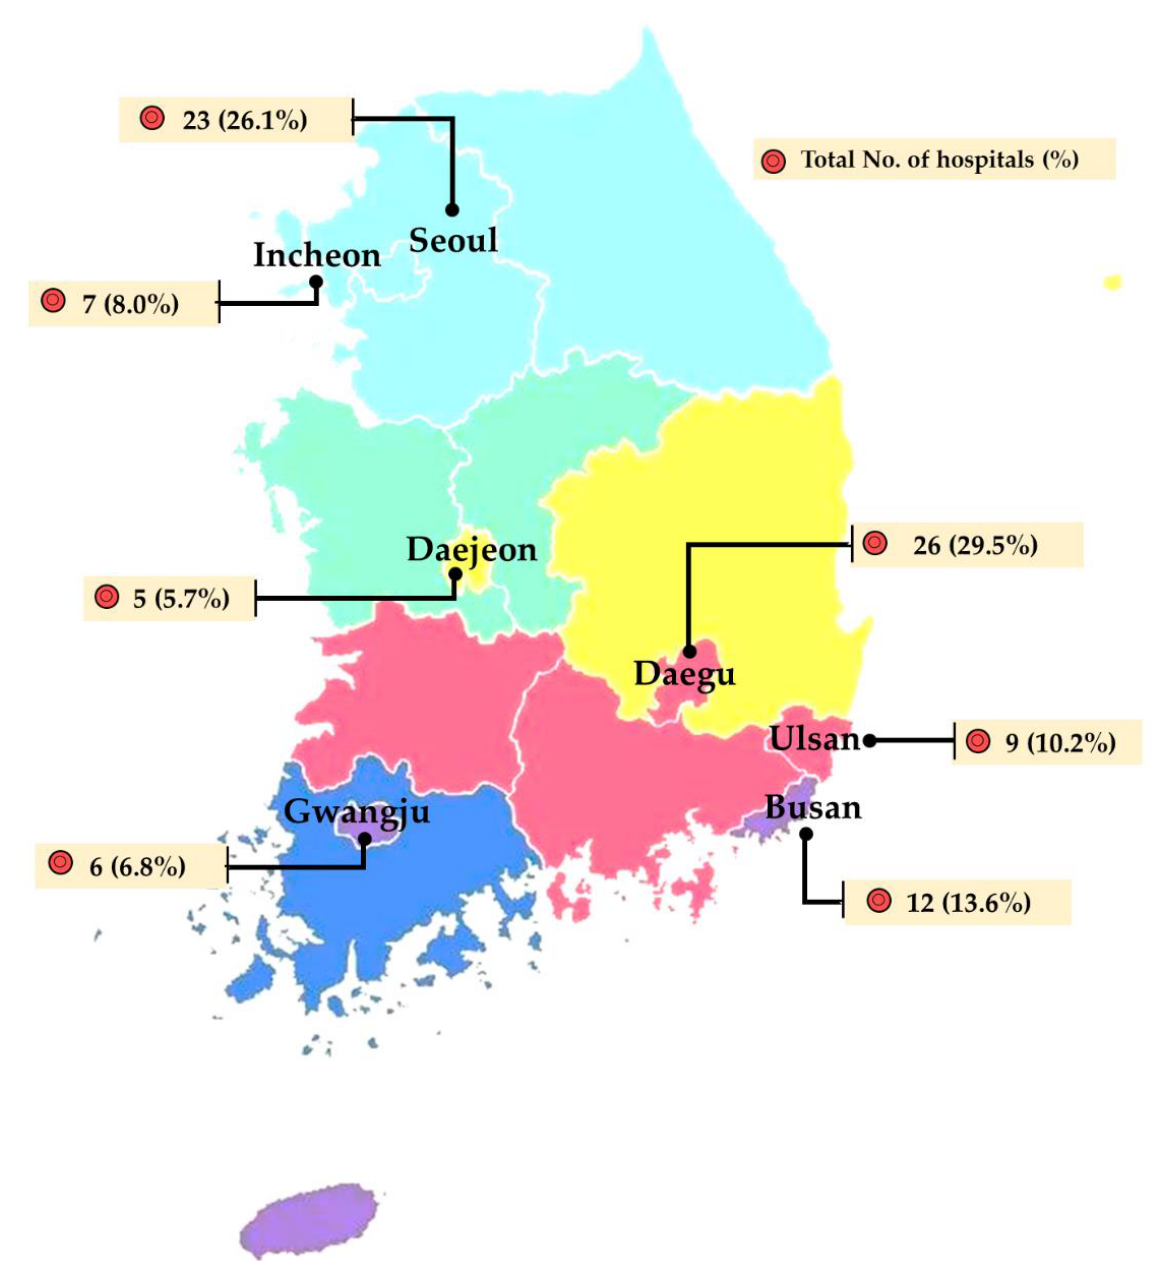
Figure 1. Demographic presentation and the total number of hospitals (%) that participated in this study from each city. In the figure, the hospitals that appeared more than one time in the study period counted as one while calculating the total number of hospitals.